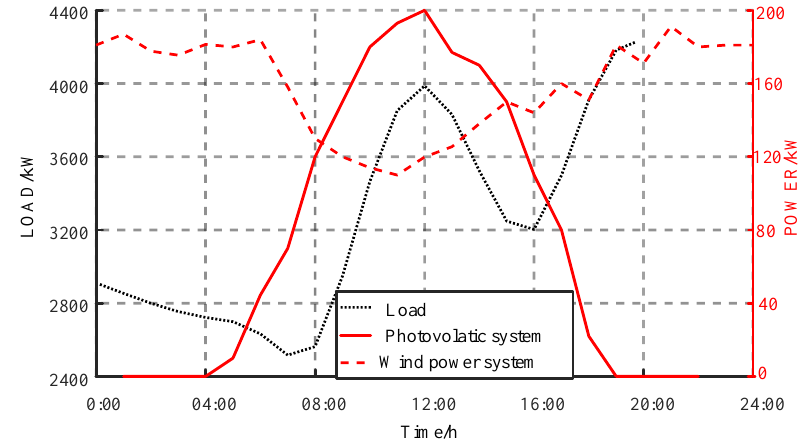
Figure 8. The typical daily characteristic curves of load, photovoltaic, and wind power.